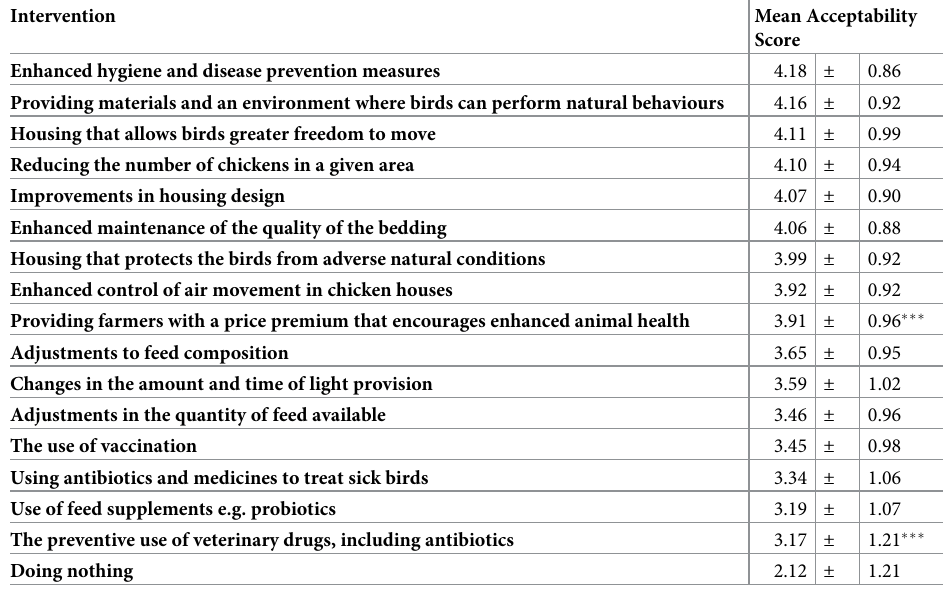
Table 6. Mean acceptability scores of interventions to control production diseases in laying hens (n = 790).